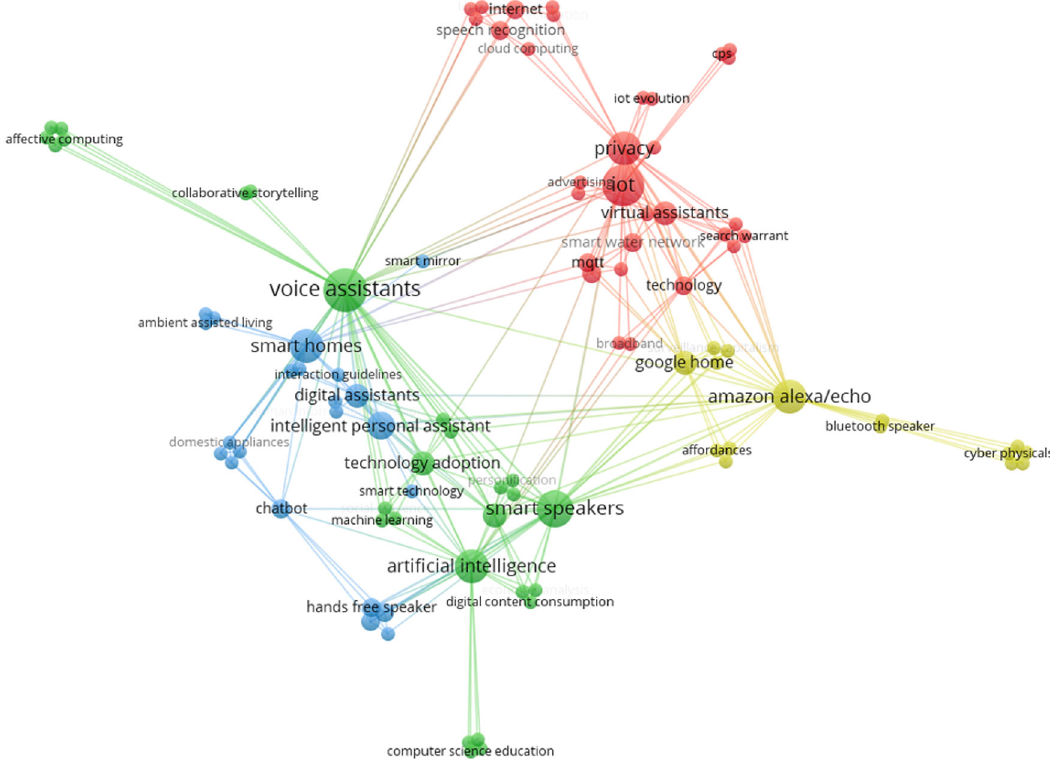
Fig. 4 Co-occurrence network for the SS research fi eld. The frequently co-occurring keywords, topics, or themes in research in the SS fi eld on VAs in private